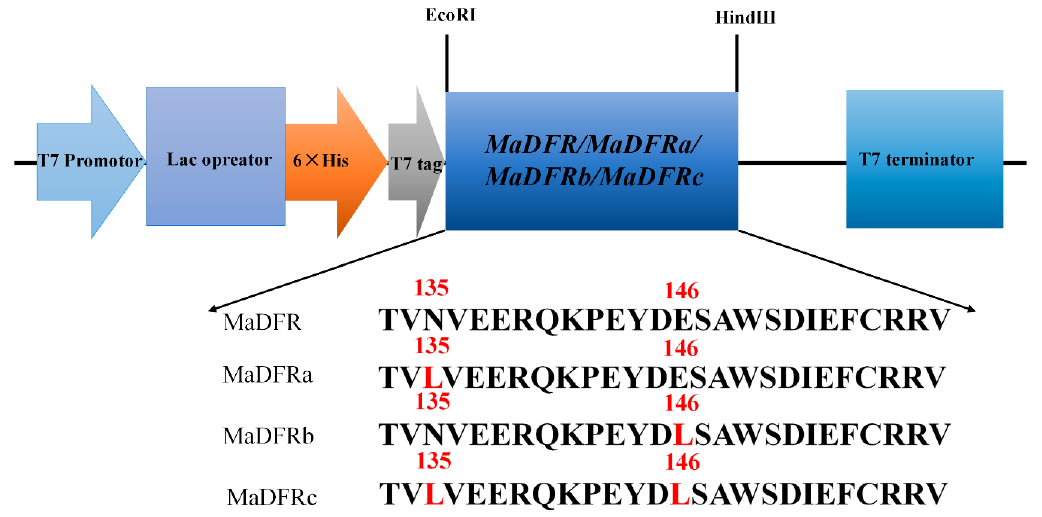
Figure 7. Schematic diagram of the T-DNA region of Site-directed mutagenesis of the region responsible for the substrate specificity of MaDFR . Amino acids in red indicate